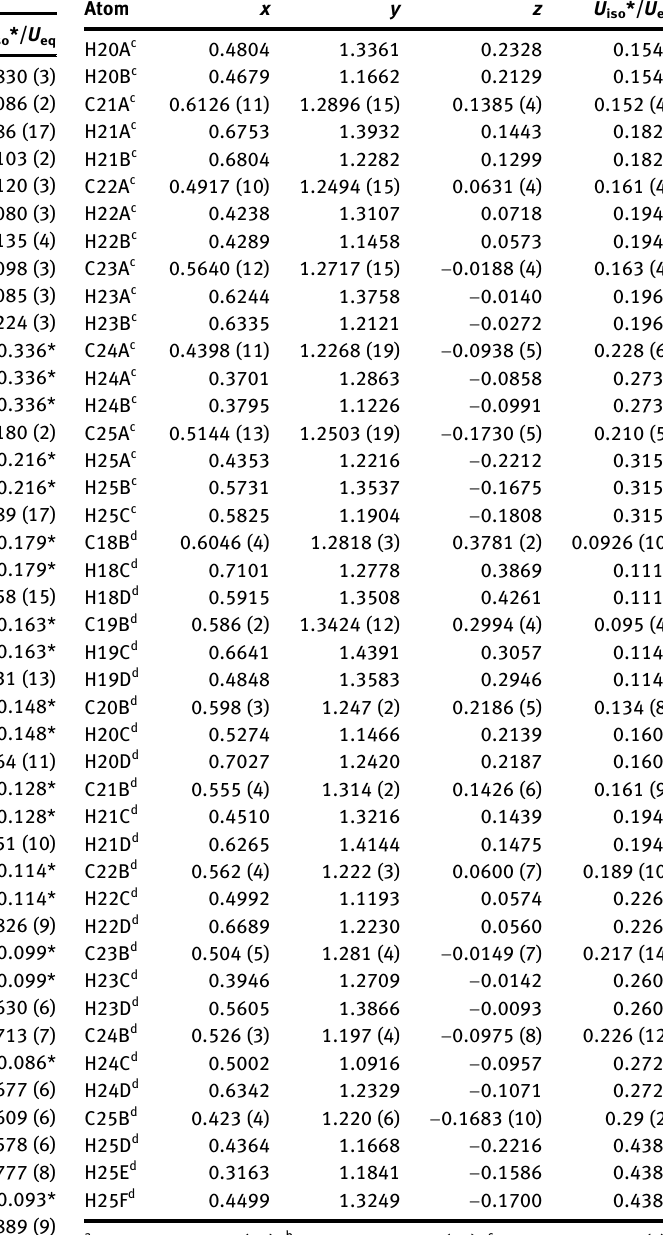
Table  : Fractional atomic coordinates and isotropic or equivalent isotropic displacement parameters (Å 